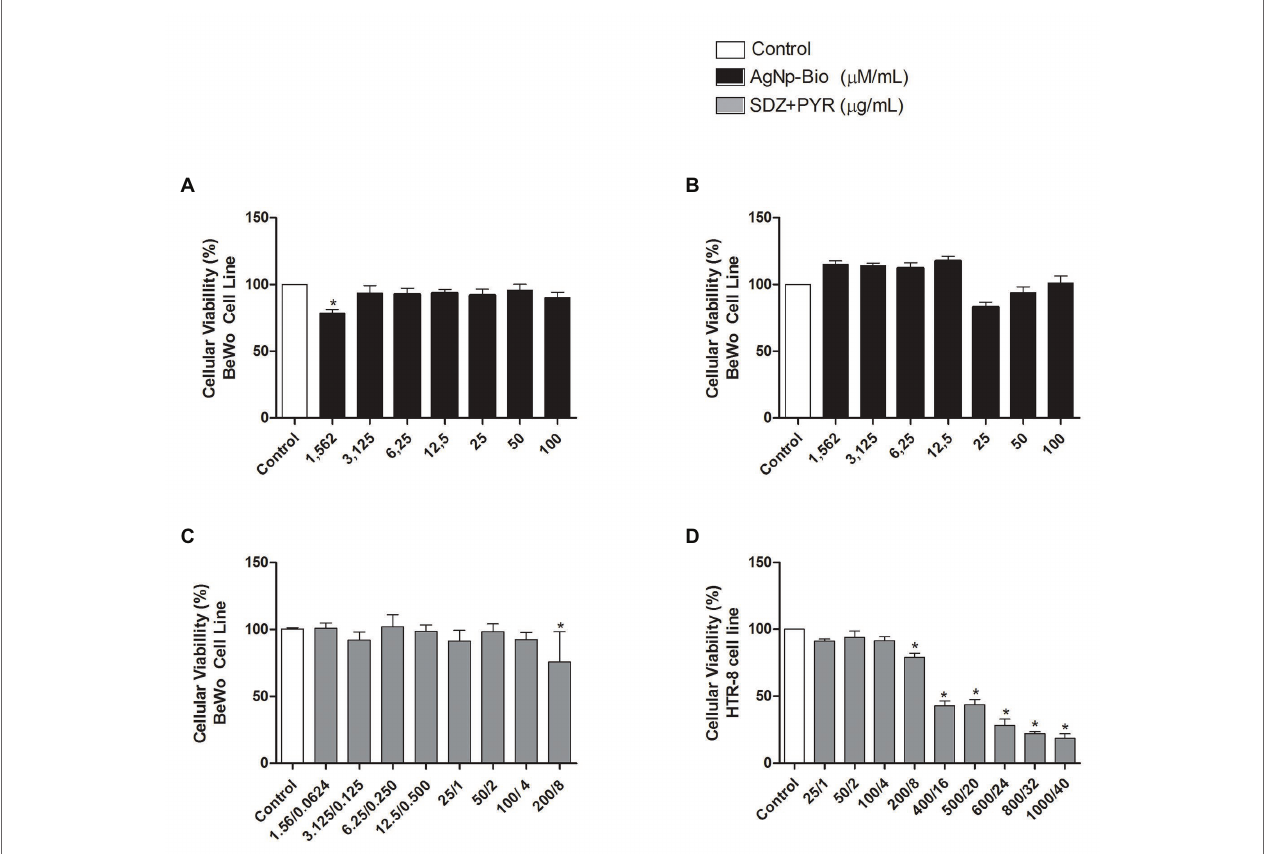
FIGURE 1 | Cellular viability after treatment with different nanoparticles concentrations. (A) BeWo cells were cultured in 96-well plates (3 × 10 4 cells/well/200 μ l) for 24 h and treated with biogenic silver nanoparticles (AgNp-Bio) concentration ( μ M/ml) or combination of sulfadiazine/ pyrimethamine (SDZ + PYR) or complete medium (negative control). (B) HTR8/SV neo cells were cultured in 96-well plates (3 × 10 4 cells/well/200 μ l) for 24 h and treated or untreated with nanoparticle in different concentrations ( μ M/ml) or complete medium (control). (C) Combination of SDZ + PYR in BeWo cells ( p < 0.05). (D) Combination of SDZ + PYR in HTR-8 cells ( p < 0.05). Data were shown as mean ± SEM from three independents experiments with nine replicates. Significant differences in relation to untreated cells (control; * p < 0.05). Differences between groups were analyzed by One-Way ANOVA with the Dunnett’s multiple comparison post hoc